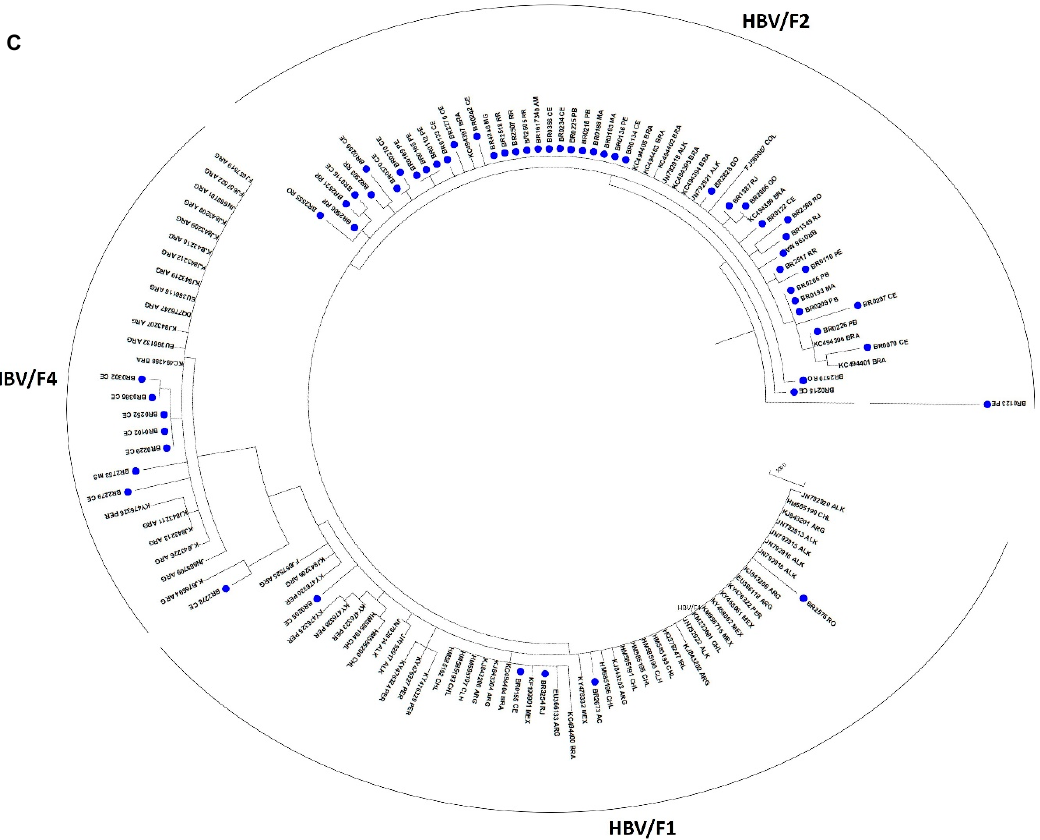
Figure 4. Phylogenetic analysis based on HBV partial S/Pol nucleotide sequences. Maximum likelihood phylogenetic trees for each genotype were constructed using (A) 177 HBV/A; (B) 66 HBV/D, and (C) 69 HBV/F sequences determined in this study and reference sequences representing all subgenotypes.